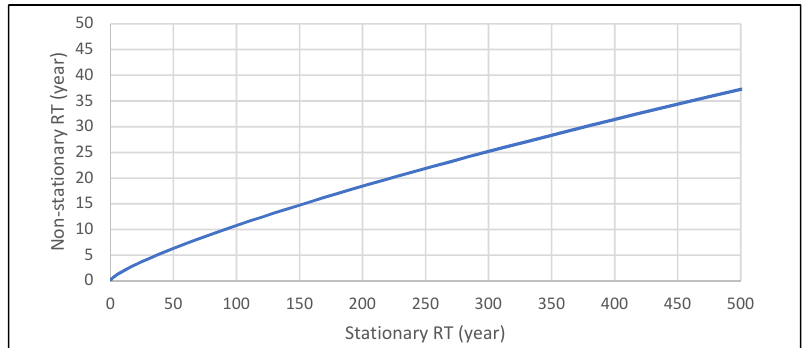
Figure 11. The relation between non-stationary and stationary RT for the year 2018.